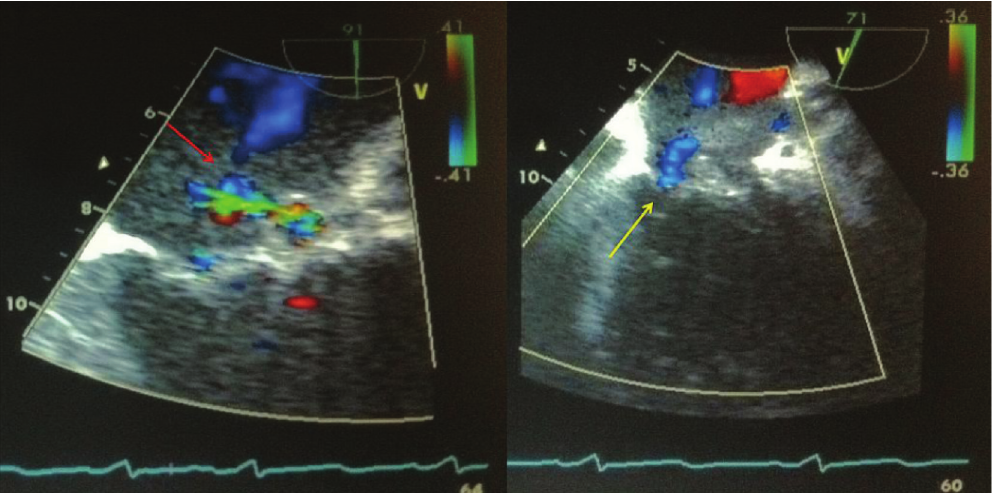
Figure 4: TEE of the mitral valve and P-MAIF demonstrating flow through the P-MAIF (red arrow) and shunt flow through the aneurysmal segment (yellow arrow) of the mitral-aortic intervalvular fibrosa (arrow